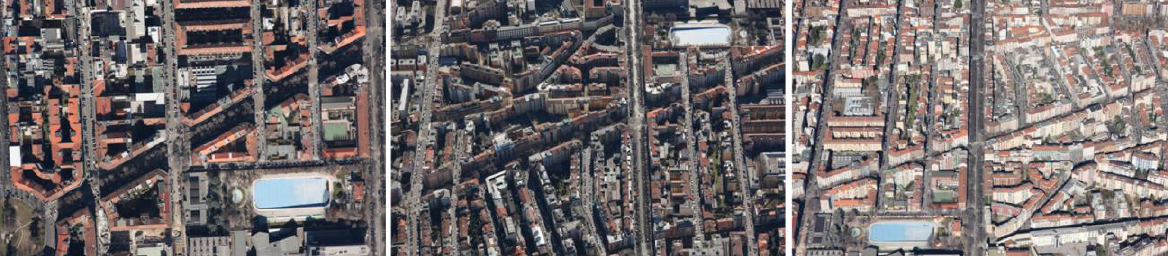
Figure 2: Same urban scene, acquired with a Midas 5 system, viewed from different perspectives (nadir and two oblique, respectively). Block configuration: it arranges cameras in a block. Similarly to the fan systems, a sufficient overlap between individual frames allows for rectification and stitching to form a single near-vertical frame of rectilinear shape. First generation Z/I DMC cameras, with four medium format cameras on-board, merged in post-processing into a large-format PAN frame is a typical example of such configuration. Other examples are Trimble AIC x4 and IGI DigiCam Quattro, carrying Rollei and Hasselblad sensor respectively. These types of camera systems are not really oblique, the single cameras are near vertical - they don’t show building façades - but they can be adapted to become oblique